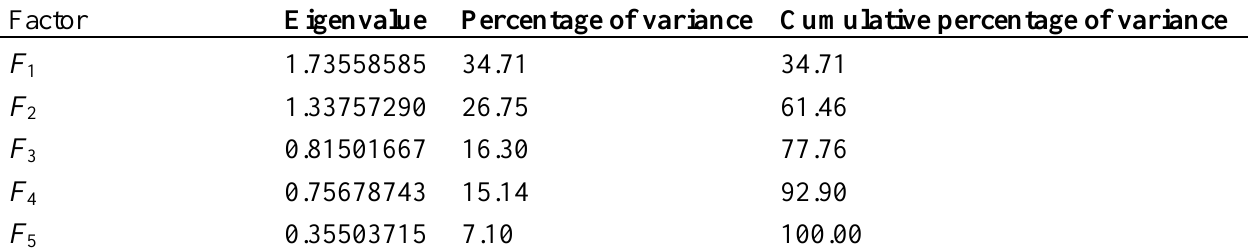
Table 4. Importance of the principal component analysis factors for the vector property.